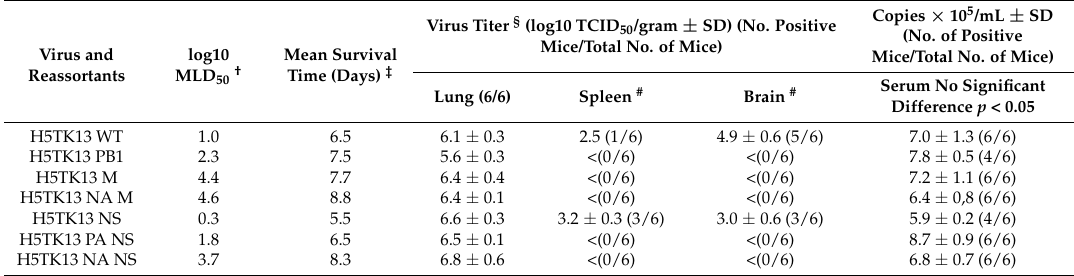
Table 2. Virulence of the H5N1/H1N1pdm09 reassortant viruses in mice. Virus and log10 Reassortants MLD 50 †